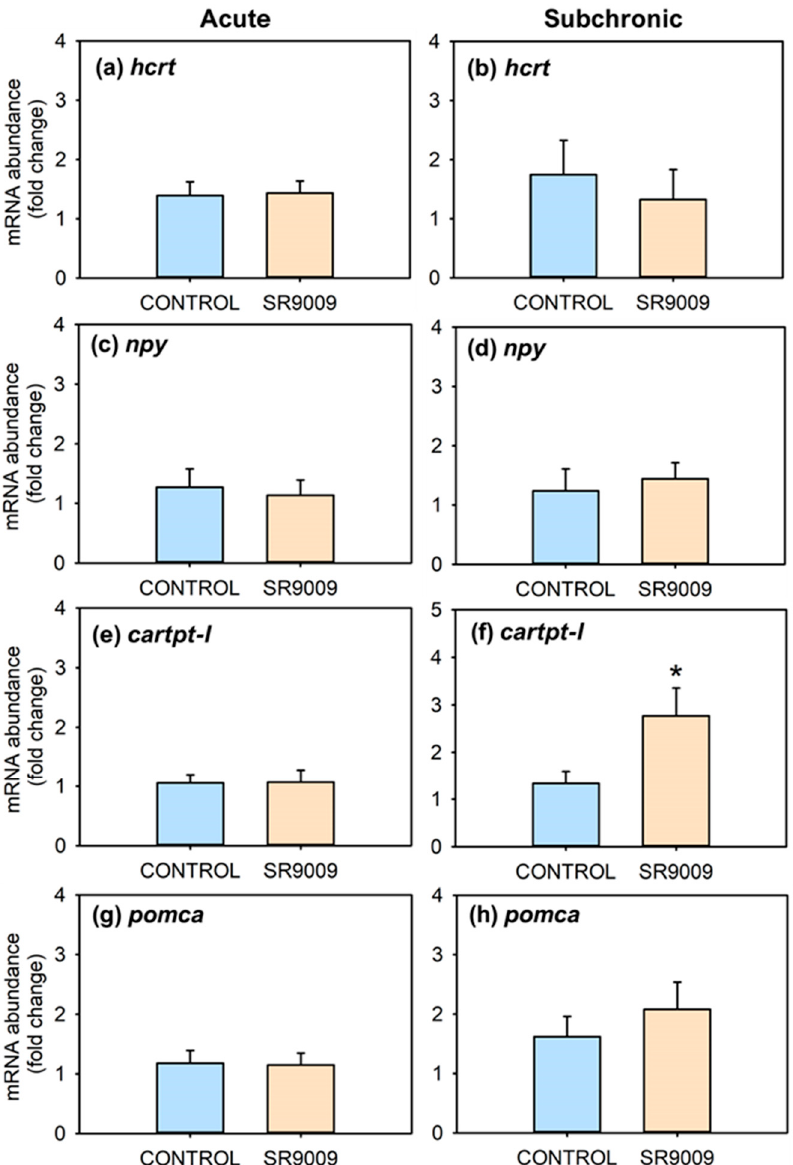
Figure 3. Effect of acute and subchronic SR9009 treatment on hypothalamic feeding regulators. Relative mRNA abundance of hcrt ( a , b ), npy ( c , d ), cartpt-I ( e , f ), and pomca ( g , h ) in the hypothalamus of goldfish ( Carassius auratus ) treated with vehicle alone (CONTROL) or containing SR9009 (100 µg/g bw). The left column shows results of the acute treatment ( n = 9 fish/group), and the right column of the 7-day subchronic treatment ( n = 12 fish/group). Data are expressed as mean + S.E.M. in relative units (2 −ΔΔ Ct ). * p < 0.05 SR9009 compared to control group (Student’s t -test).